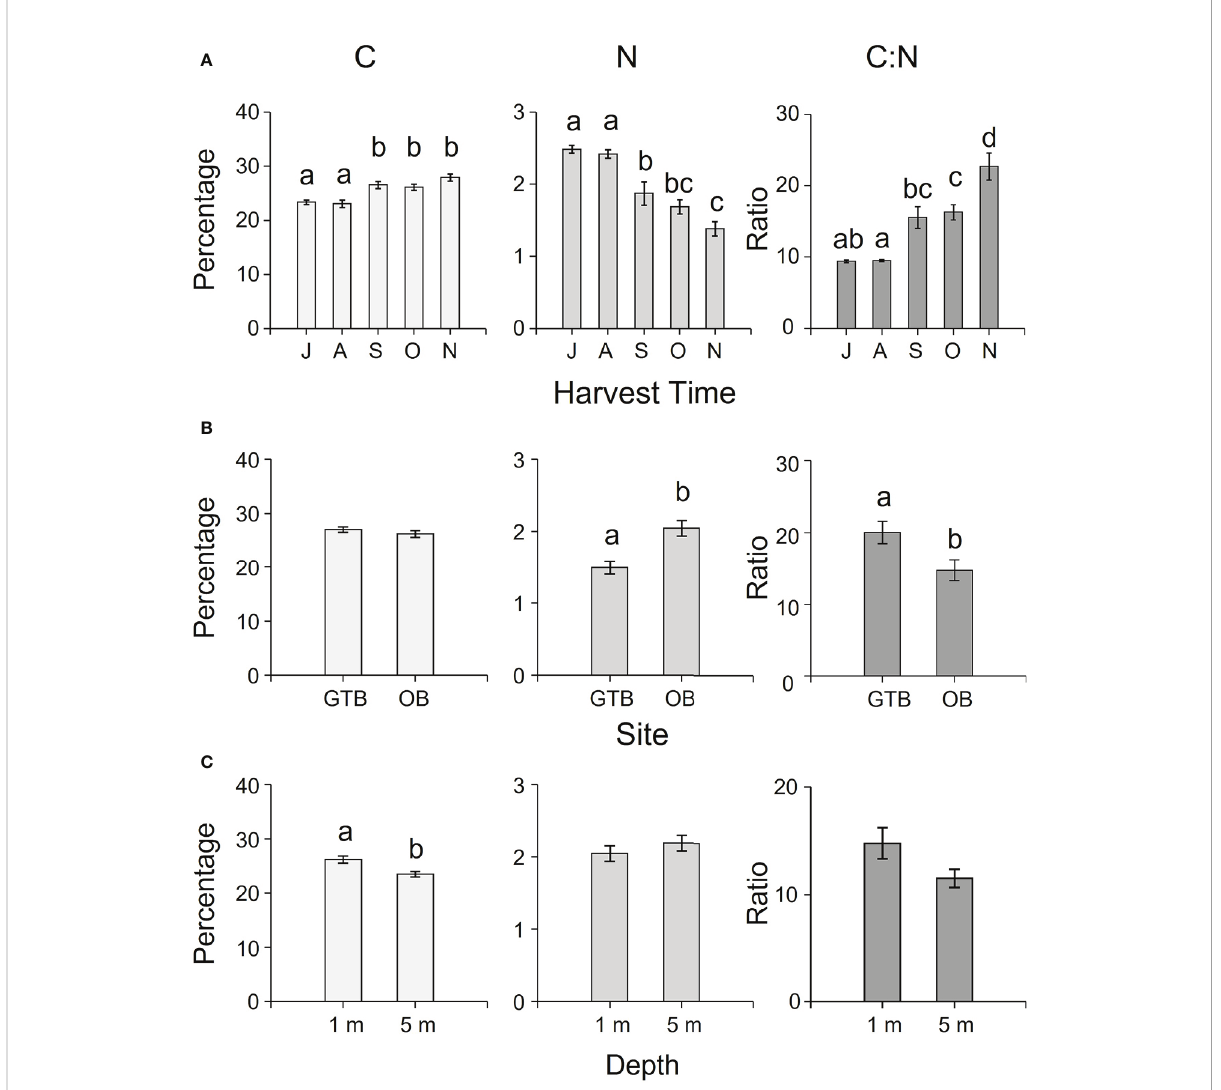
FIGURE 5 Mean (± SEM) percentages of C, N and C:N ratio of cultivated M. pyrifera according to (A) harvesting time (J = July, A = August, S = September, O = October, N = November), (B) site (GTB = Great Taylor Bay, OB = Okehampton Bay), and (C) depth (1-m and 5-m for Okehampton). Different letters above bars represent signi fi cant differences (P < 0.05) amongst the relevant factors from Tukey ’ s HSD